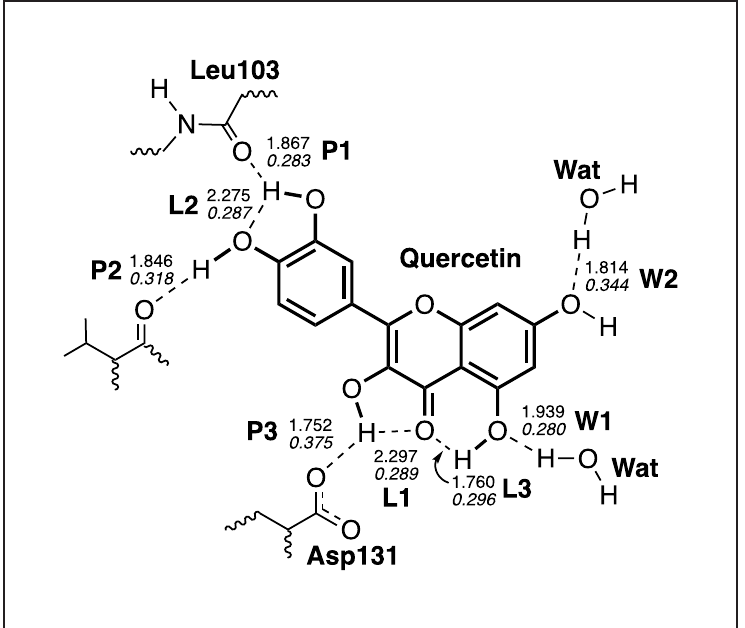
Figure 16. Hydrogen bonds in the Quercetin-NS5 complex (dashed lines). Bond lengths are shown in the normal font, BSO values are shown in the italic font. ω B97X-D/6-31G(d,p)/AMBER level of